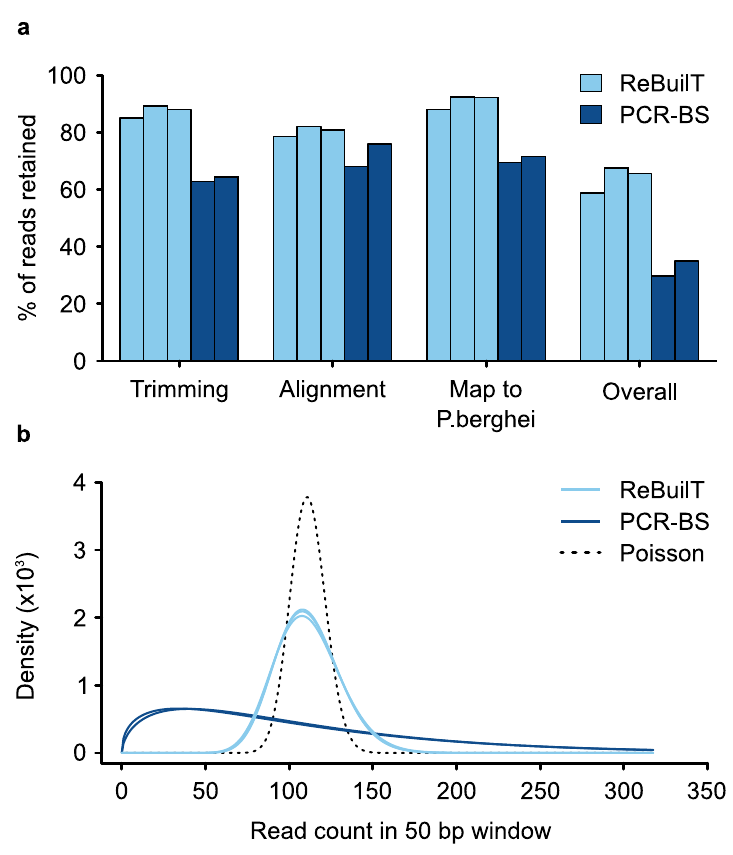
Fig 2. ReBuilT produces superior quality sequence data. (a) Retention of raw data through bioinformatic preprocessing. Trimming indicates removal of adapter or low-quality sequences; alignment was to a chimeric P. berghei / M. musculus genome to remove host contamination; Map to P. berghei shows the fraction of reads aligning to the parasitic genome. ReBuilT retained almost twice percentage of raw data. (b) The distribution of mapped reads in 50 bp windows across the genome. The Poisson distribution (dashed line) describes the ideal distribution in the absence of external biases. REBUiLT approximates this distribution, while PCR-BS does